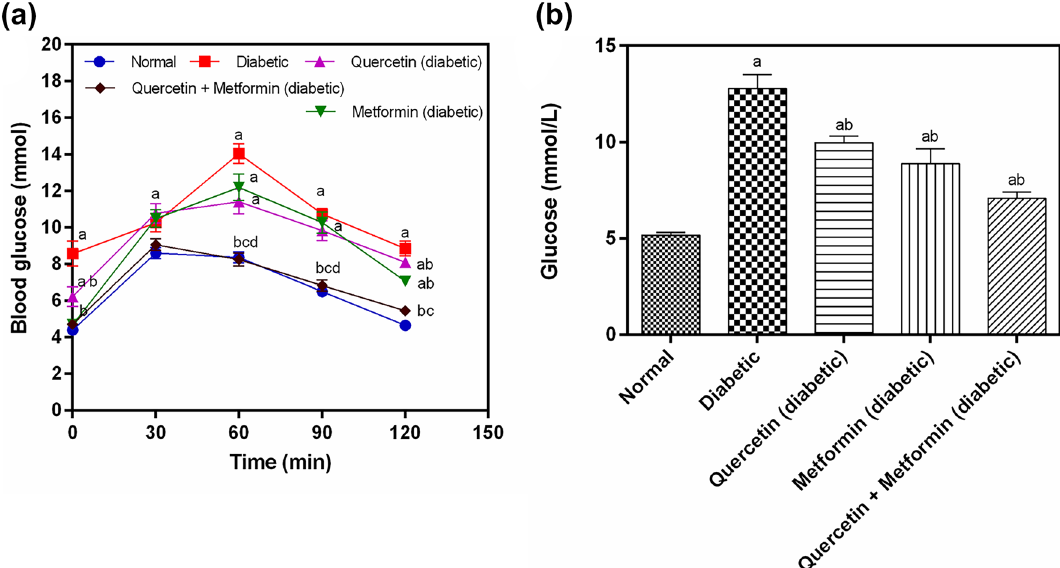
Figure 1. Effect of test compounds on, ( a ) oral glucose tolerance test, ( b ) on plasma glucose in diabetic rats. Data represent mean ± SEM. The alphabet, ‘a’ shows a significant difference in comparison with normal control ( p < 0.05). The alphabet, ‘b’ shows a significant difference in comparison to diabetic control ( p < 0.05). The alphabet, ‘c’ shows a significant difference in comparison with a quercetin treatment group ( p < 0.05). The alphabet, ‘d’ shows a significant difference in comparison with the metformin treatment group ( p <